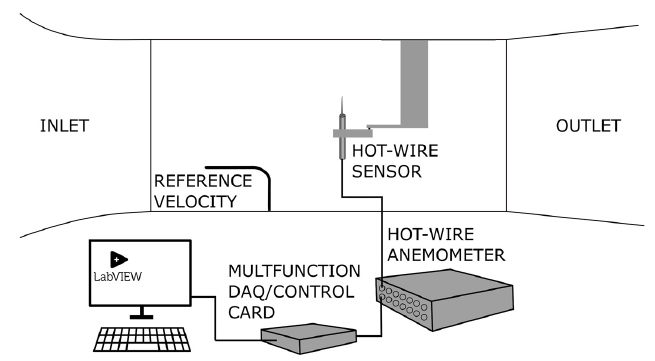
Figure 4. Measurement setup diagram.